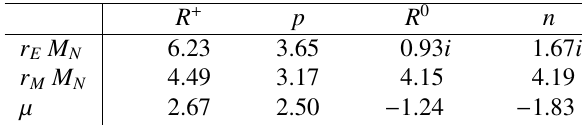
Table 1. Static properties derived from the elastic form factors depicted in Fig.3, see Eq.(5) and following